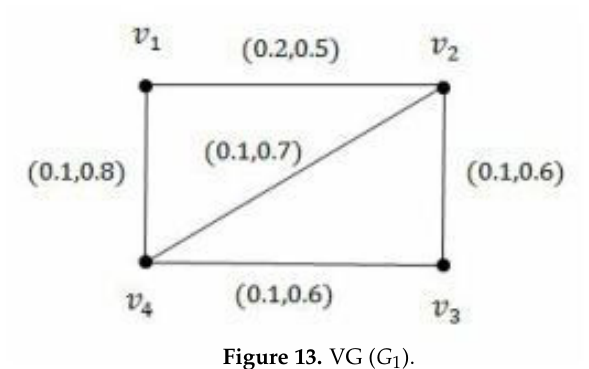
Figure 13. VG ( G 1 ).